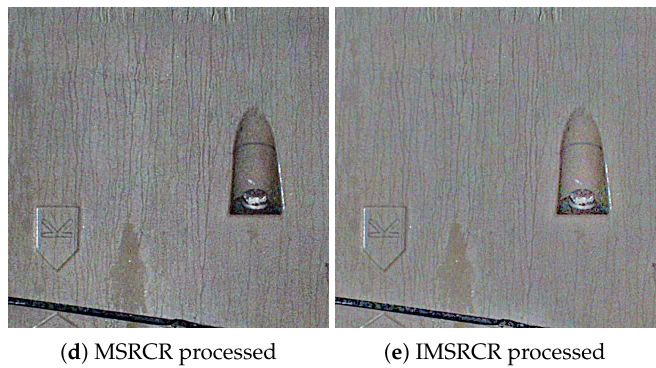
Figure 5. Effect comparison of different image enhancement